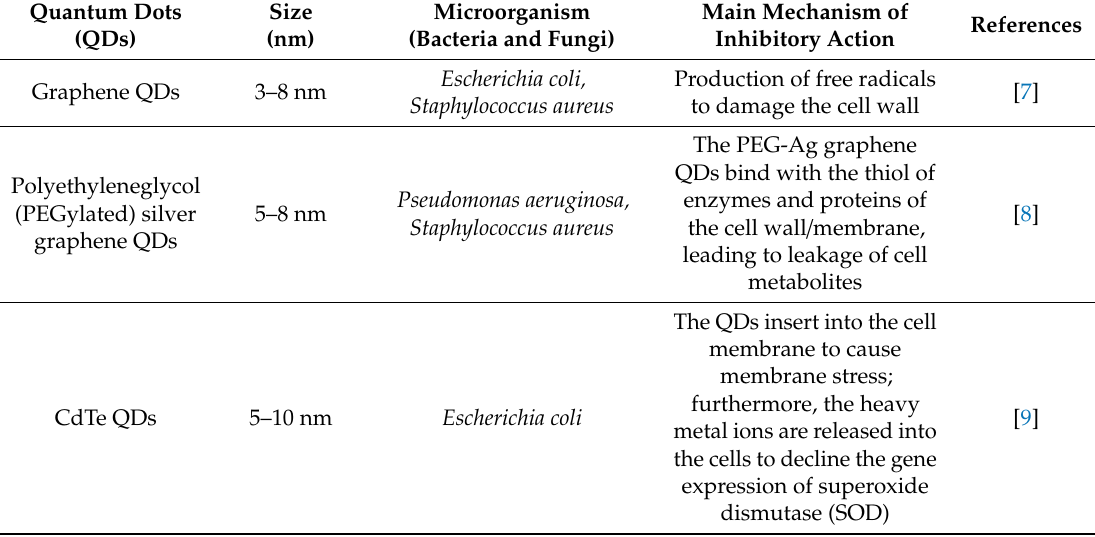
Figure 1. General antimicrobial mechanism of quantum dots (QDs). QDs produce antimicrobial effects through destroying cell walls/membranes, inducing free radicals, binding with genetic material, and inhibiting energy production. Table 1. List of quantum dots (QDs) and their mechanisms of inhibitory action on bacteria and fungi. Quantum